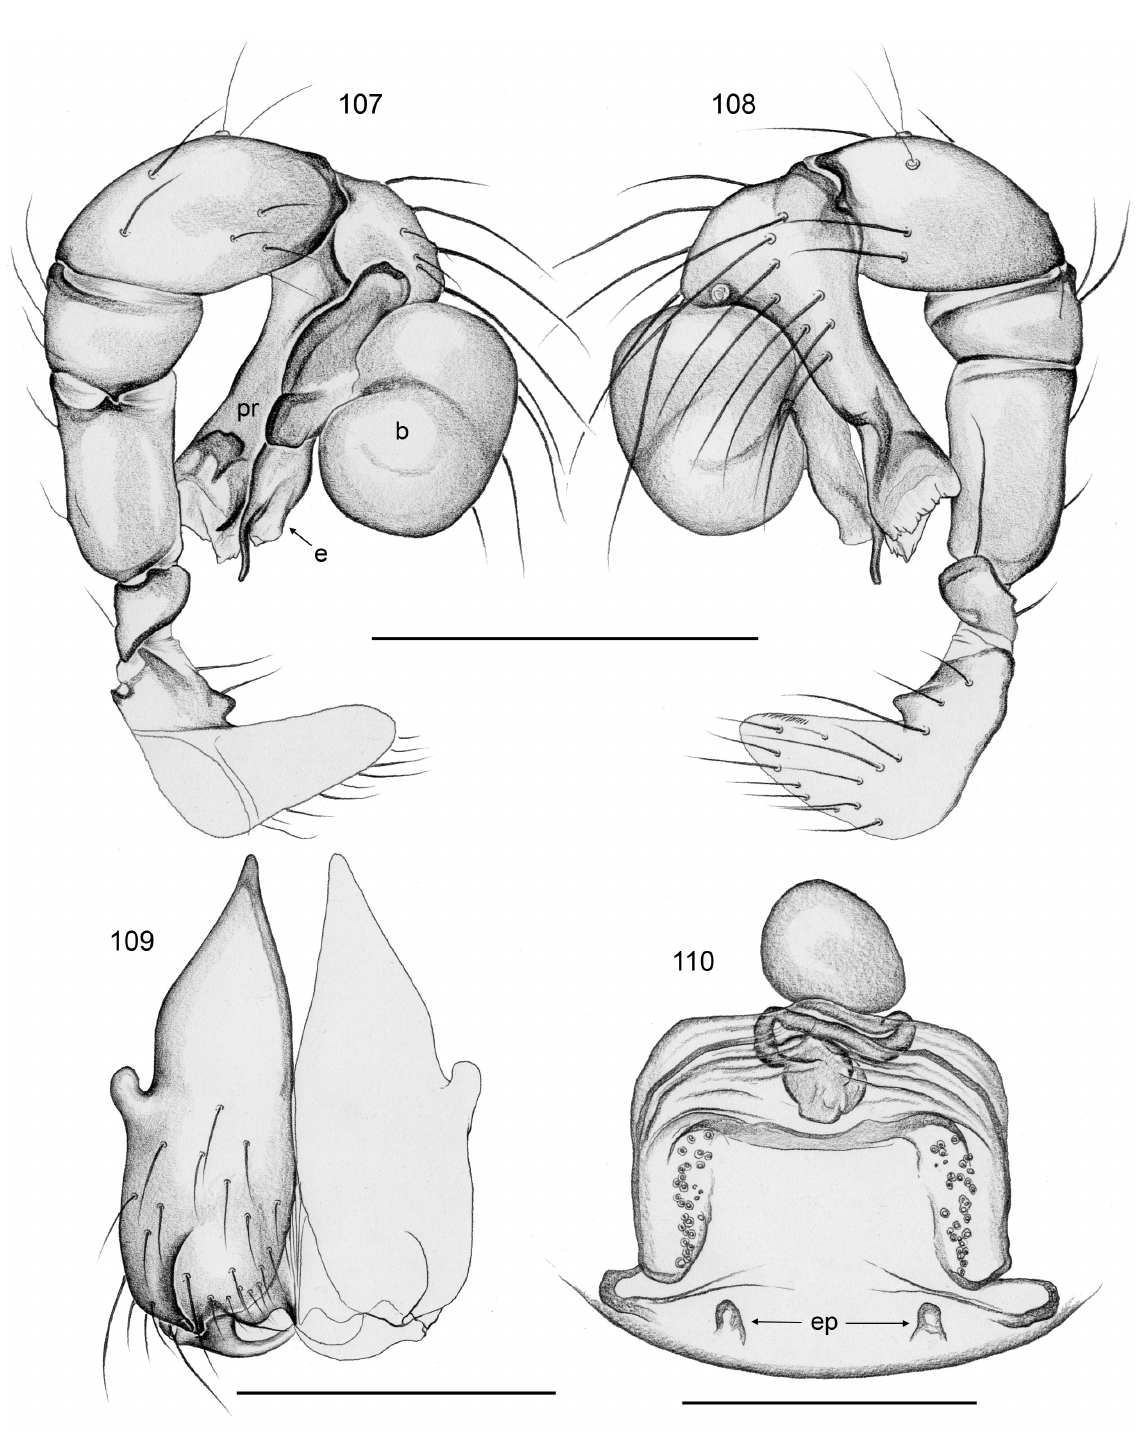
Figs 107-110. Spermophora kyambura sp. nov. 107-108. Left ♂ palp, prolateral and retrolateral views. 109. ♂ chelicerae, frontal view. 110. ♀ genitalia, cleared dorsal view. b: genital bulb; e: embolus; ep: epigynal pockets; pr: procursus. Scale lines: 0.2 mm (109-110), 0.3 mm